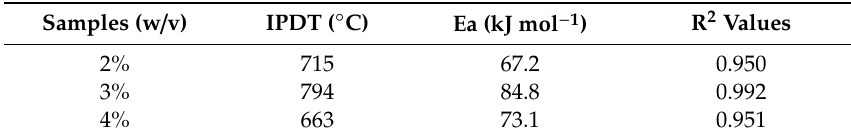
Table 3. Integral decomposition temperature (IPDT) values and activation energy of the films using the Broido